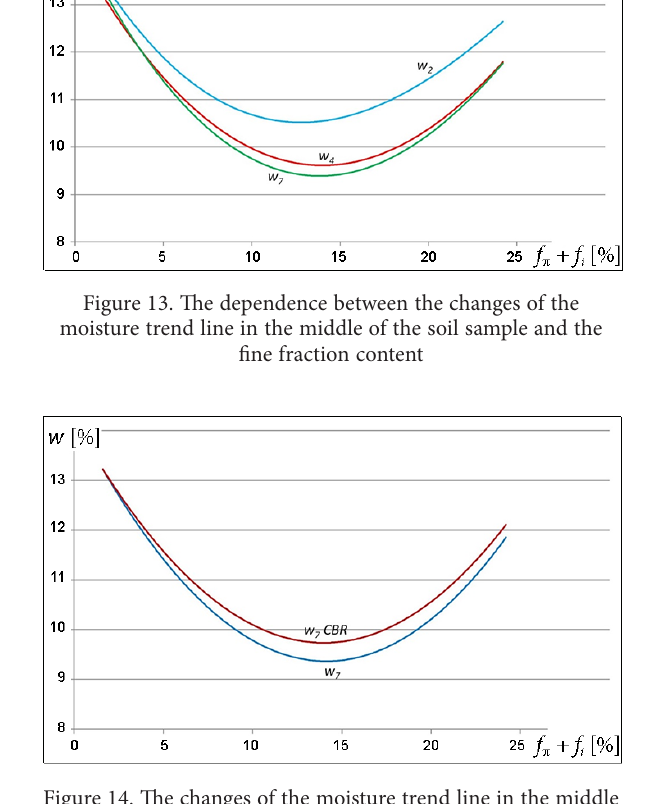
Figure 14. The changes of the moisture trend line in the middle of the soil sample before and after the CBR test with regard to the fine fraction content